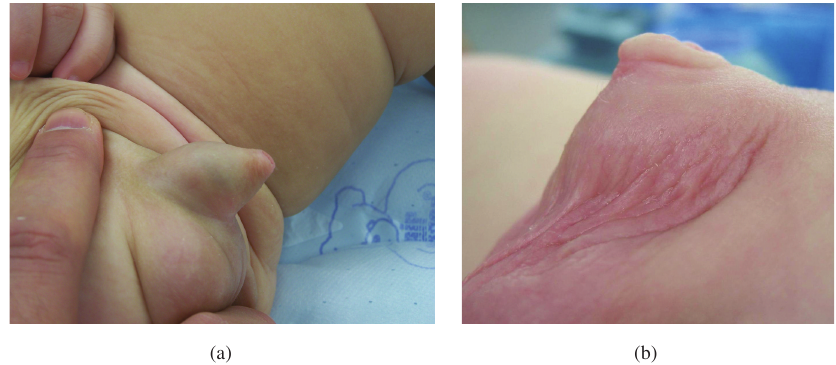
FIGURE 2: Webbed penis. (a) Lateral view of a young boy with mild-moderate penoscrotal webbing. In mild cases, fixation of the angle to Buck’s fascia of the penis can reconstruct the angle and the penis refashioned with the residual skin. In more severe cases (b), the webbing is divided and the skin reapproximated in the ventral midline for penile skin